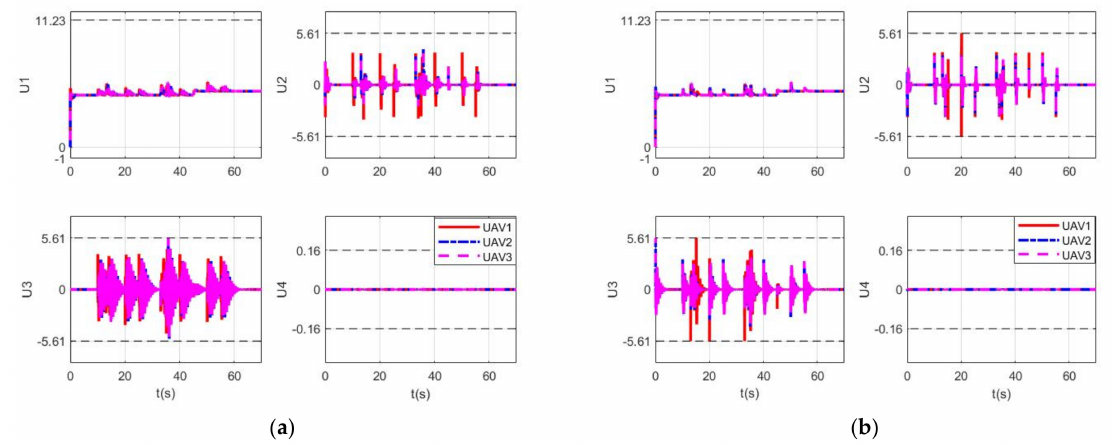
Figure 16. States of RS for UAVs with RMAC ( a ) and IMPC ( b ). The angle of IMPC returns to the steady state faster than RMPC, which demonstrates that IMPC has better performance than RMPC.